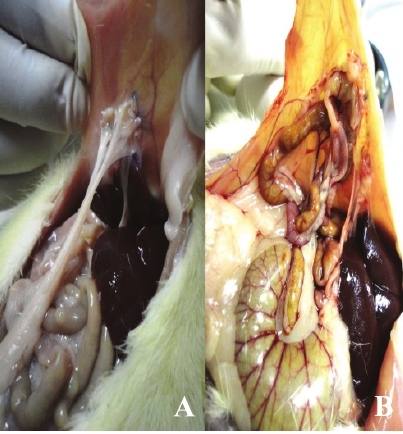
FIGURE 3 - Presence of the intraperitoneal adhesions using polyester mesh with collagen ( A ) and polytetrafluoroethylene ( B